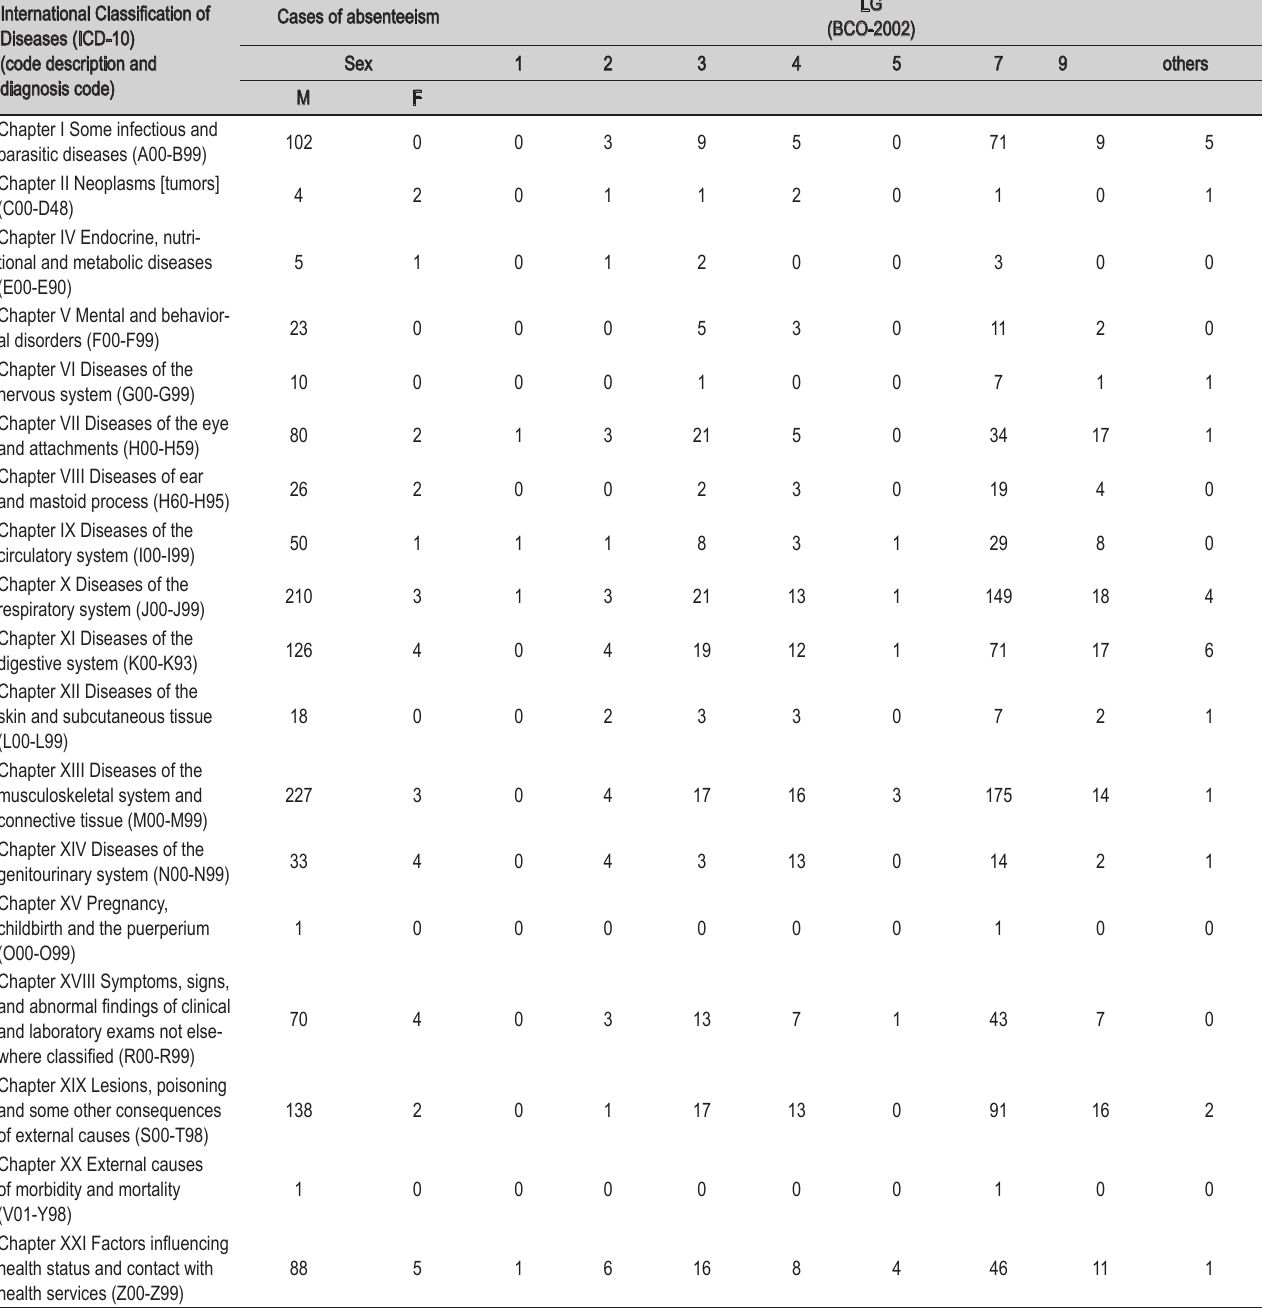
Table 4 - Distribution of the number of cases of absenteeism according to the International Classification of Diseases (ICD-10), sex (male and female) and LG